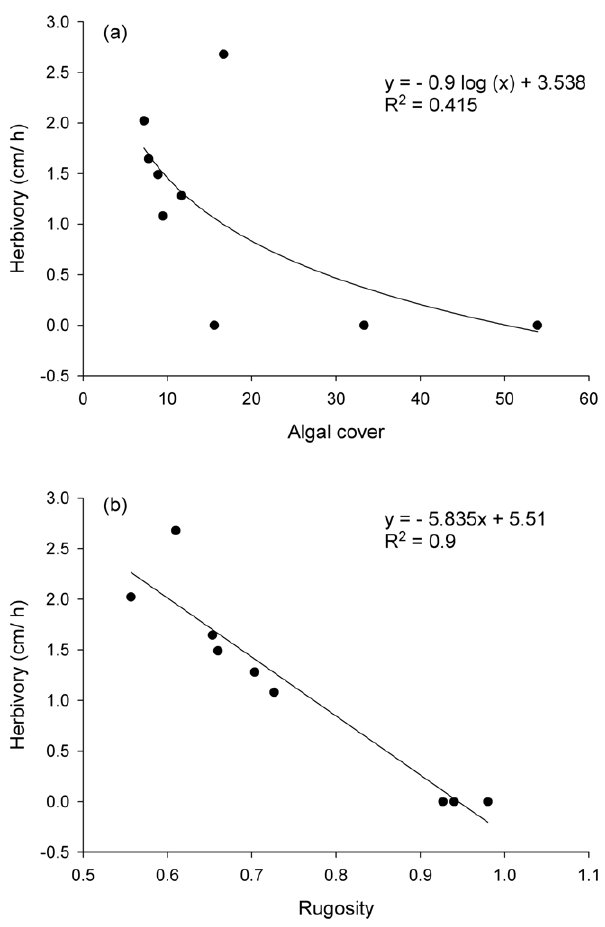
Figure 5. Experimental test of effects of habitat and herbivory on algal consumption, productivity and chemical composition. (a) Biomass change and (b) nitrogen and (c) carbon/nitrogen ratio of Lobophora variegata transplanted to reef flat and lagoon habitats in three experimental treatments designed to manipulate access by herbivores (Caged, Open and Partially caged) after 6 weeks. Data pooled across the three sites, bars represent means 6 SE.